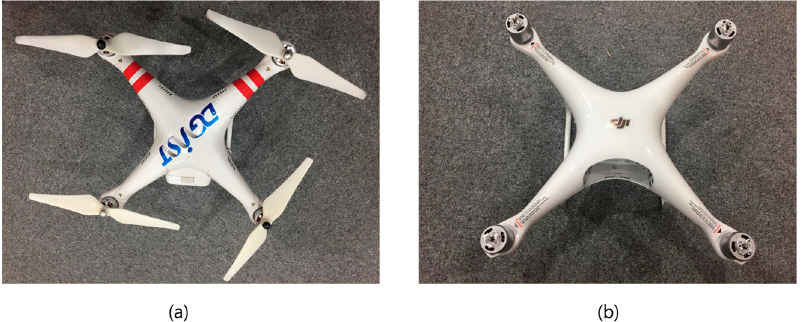
Figure 15. Photographs of drones used in the experiments, ( a ) quadcopter drone 1 (QD1); ( b ) quadcopter drone 2 (QD2).